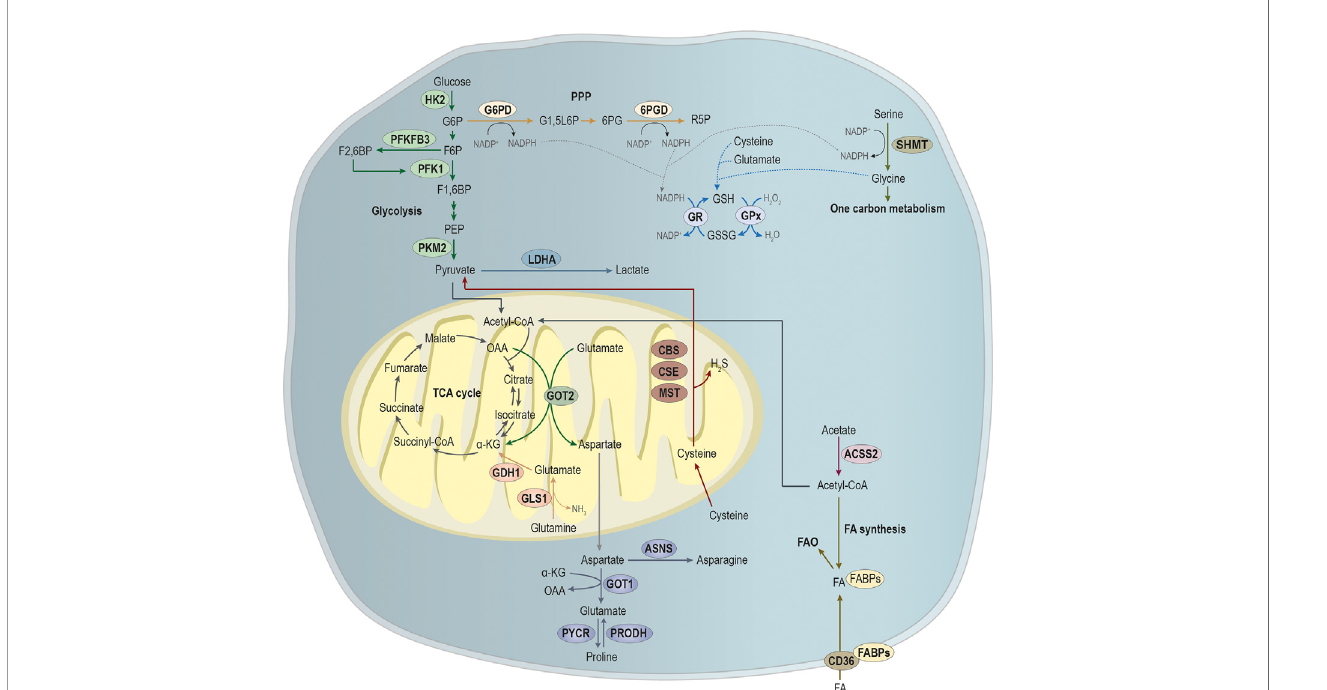
FIGURE 2 | Main pathways involved in the metabolic remodeling of metastatic cancer cells, pivotal for energy and biomass production. Metastatic cancer cells are metabolically more plastic than non-metastatic cancer cells, because they need to survive in primary tumor microenvironment, and they must also prosper in the microenvironment of the metastasized organ. Glycolysis is a multi-step process, in which the expression of key glycolytic enzymes as hexokinase 2 (HK2) that converts glucose in glucose-6-phosphate (G6P), 6-phosphofructo-2-kinase/fructose-2,6-biphosphatase 3 (PFKFB3) that promotes the conversion of fructose-6- phosphate (F6P) in fructose-2,6-biphosphate (F2,6BP; an allosteric activator of the glycolytic enzyme phosphofructokinase 1 (PFK1)) and pyruvate by tumor M2- pyruvate kinase (PKM2) that synthesizes pyruvate from phosphoenolpyruvic acid (PEP) have been showed to be involved in metastases establishment. Pyruvate is an endpoint product of glycolysis that after its conversion into acetyl-CoA, which can alternatively be produced from acetate, under the action of acyl-coenzyme A synthase short-chain family member 2 (ACSS2), then it will supply the tricarboxylic acid (TCA) cycle or the synthesis of fatty acids (FA). Additionality, FA can be imported by CD36, being the FA pool deviated to FA b-oxidation (FAO). Glycolysis intermediate glucose-6-phosphate (G6P) can be diverged from glycolysis to supply phosphate pentose pathway (PPP) through the action of glucose-6-phosphate dehydrogenase (G6PD), catalyzing the conversion of G6P into glucono-1,5- lactone-6P (G1,5L6P) and generating nicotinamide adenine dinucleotide phosphate (NADPH). The 6-phosphogluconate dehydrogenase (6PGD) converts 6- phosphogluconate (6PG) into ribose-5-phosphate (R5P), concomitantly with NAPDH production. Amino acids metabolism is crucial in biosynthesis and bioenergetics. The serine and glycine syntheses and the one-carbon metabolism play a central role in cell metabolism. The action of serine hydroxymethyltransferase (SHMT) catalyzes the conversion of serine into glycine, generating NADPH. NAPDH will be essential for the reduction of glutathione disul fi de (GSSG) into glutathione (GSH) by the action of glutathione reductase (GR). In turn, the oxidation of GSH in GSSG by glutathione peroxidase (GPx) is essential for the control of the redox state of metastasizing cancer cells. Moreover, cysteine, glutamate and glycine are used in GSH synthesis. Glutamine catabolism through the action of glutaminase 1 (GLS1) leads to the production of glutamate and ammonia (NH 3 ). In turn, glutamate dehydrogenase 1 (GLDH1) converts glutamate into a -ketoglutarate ( a -KG) that will ful fi ll TCA cycle. In mitochondria, glutamate is a target of glutamic-oxaloacetic transaminase 2 (GOT-2), producing a -ketoglutarate ( a -KG) and aspartate, at the expense of oxaloacetate (OAA). In cytoplasm, the action of GOT-1, at the expense a -KG, leads to glutamate production that can be converted into proline by the action of proline dehydrogenase (PRODH). Moreover, pyrroline-5-carboxylate reductase (PYCR) catalyzes the inverse reaction, leading to the conversion of proline into glutamate. Aspartate catabolism by asparagine synthetase (ASNS) promotes asparagine synthesis. Cysteine in cytoplasm is essential for GSH synthesis while in mitochondria, its catabolism by the cystathionine- b -synthase (CBS) route; the cystathionine- g -lyase (CSE) route and the CAT/GOT:3-mercaptopyruvate sulfurtransferase (MST) axis route leads to the production of pyruvate and hydrogen sul fi de (H 2